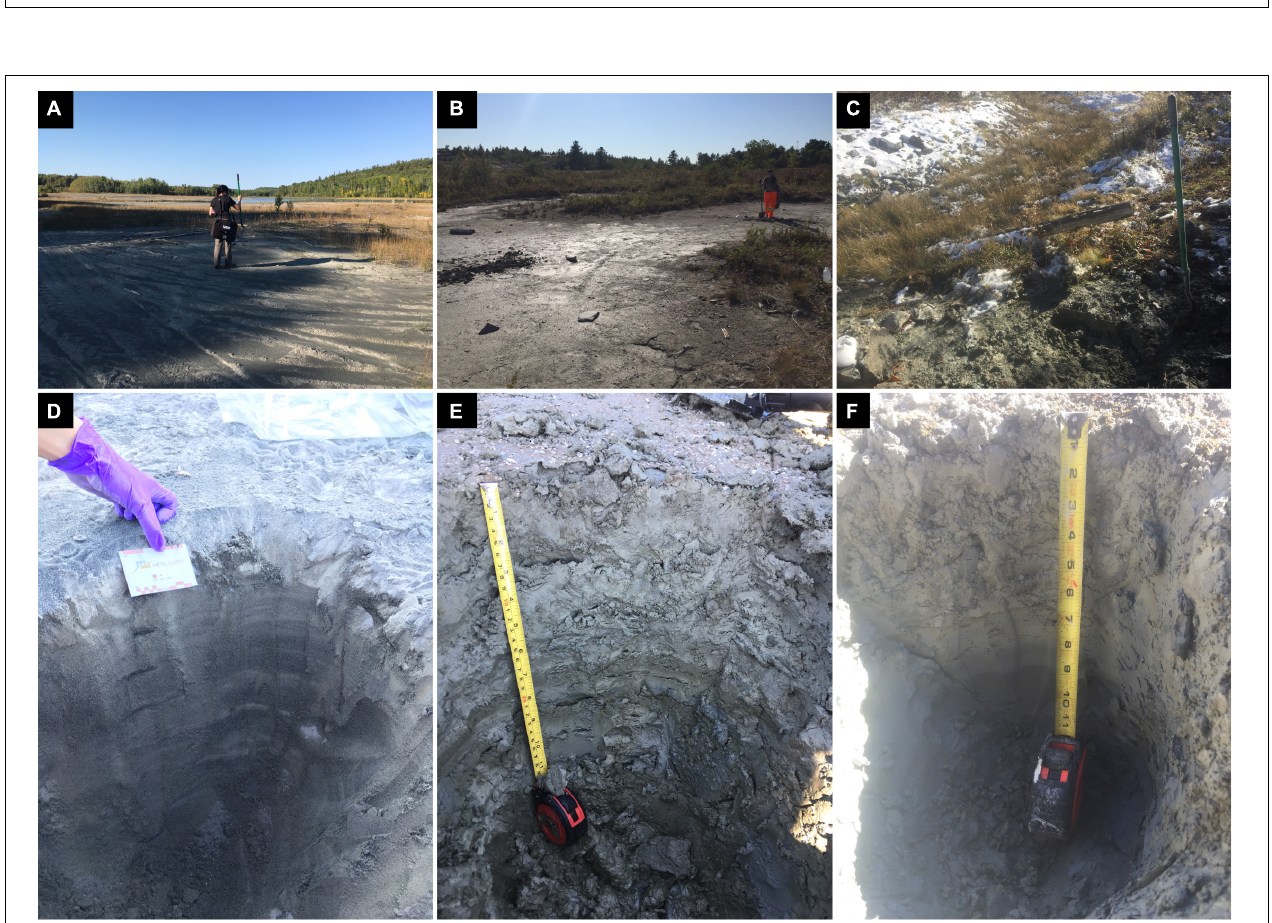
FIGURE 2 | Photographs of the three tailings sites with their 30-cm depth profiles, showing site A (A,D) , B (B,E) , and C (C,F) at the day of sampling.